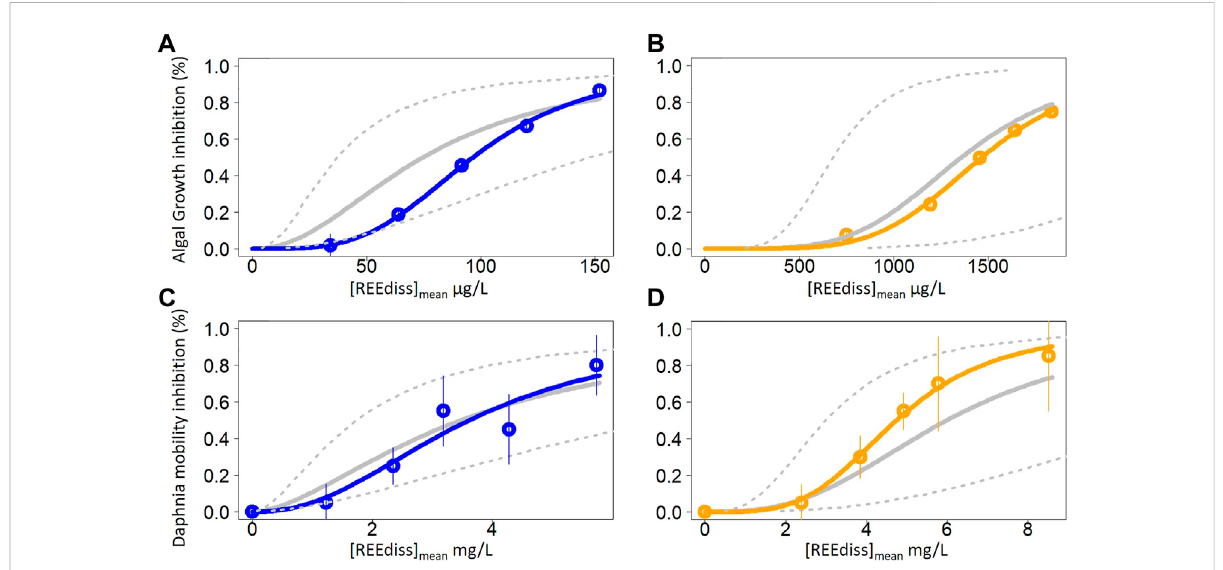
FIGURE 2 Dose response curves of the ternary mixtures for Raphidocelis subcapitata (A,B) and Daphnia magna (C,D) in the absence (A,C) and presence (B,D) ofdissolvedorganicmatter.Thecoloureddotsandsolidlinerefertotheobservedeffects.Eachdotrepresentsthemeanof3and4replicatesin algal and crustacean test, respectively. Vertical bars represent standard deviation. The grey solid line corresponds to the predicted effects according to concentration addition model. The dashed lines represent the ratios 0.5 (upper line) and 2 (lower line) corresponding to the interval of additivitypredictions.Mixtureeffectsareadditivewhenobservedeffectsareincludedbetweenthetwodashedlines,synergisticorantagonisticwhen observedeffectsareabovetheupperlineorbelowthelowerline,respectively.Thedoseresponsecurvesandcon fi denceintervalwereplottedwithR software.Aloglogistic2-parametermodelwasusedto fi tthedata[REEdiss] mean = √ (C0*C1))whereC0referstothenominalconcentrationatt0and C1 refers dissolved concentration measured at